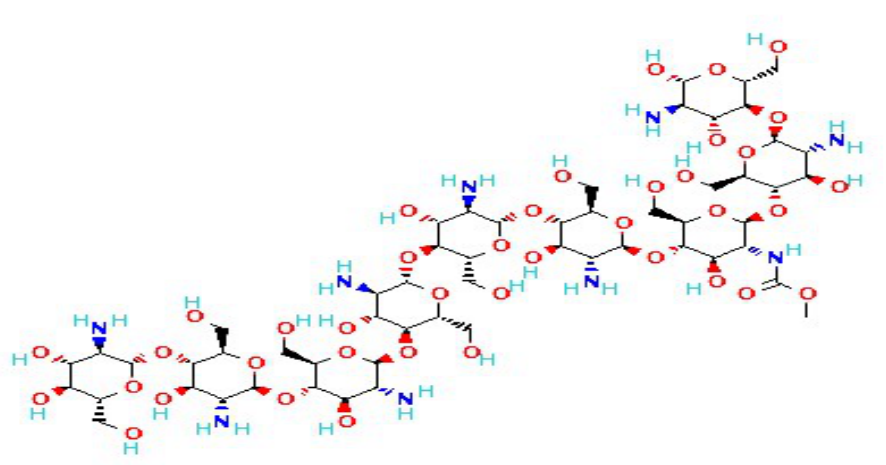
Figure 2. Chemical structure of the chitosan: Source Pubchem (https://pubchem.ncbi.nlm.nih.gov/; Accesed : September 10, 2022).